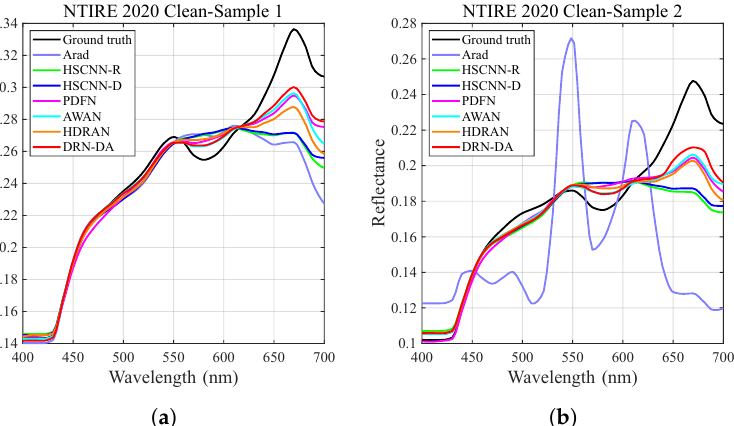
Figure 13. Spectral reflectance of selected samples from the NTIRE 2020 “Clean” track. ( a ) Sample 1. ( b ) Sample